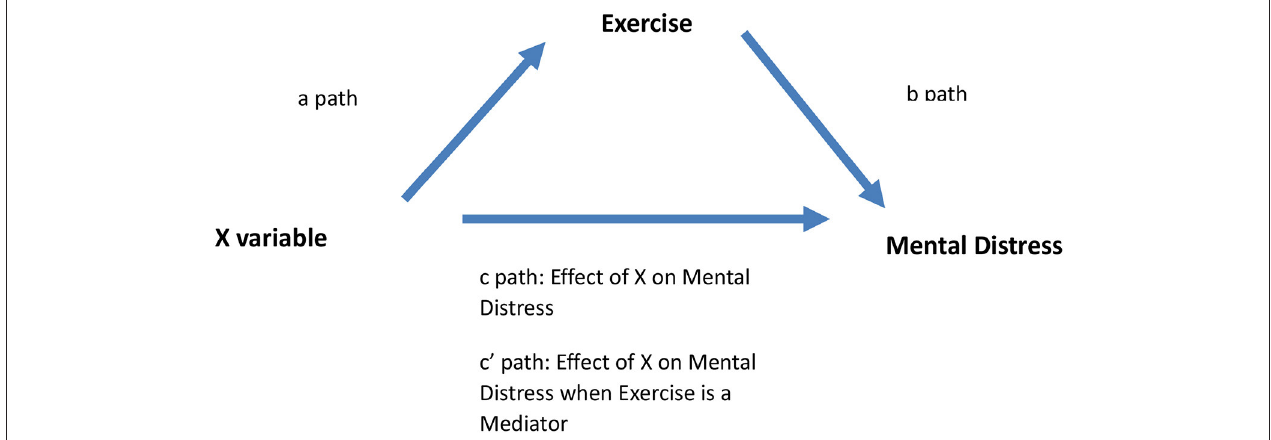
FIGURE 2 | The 3 paths of the mediation model analyzed.